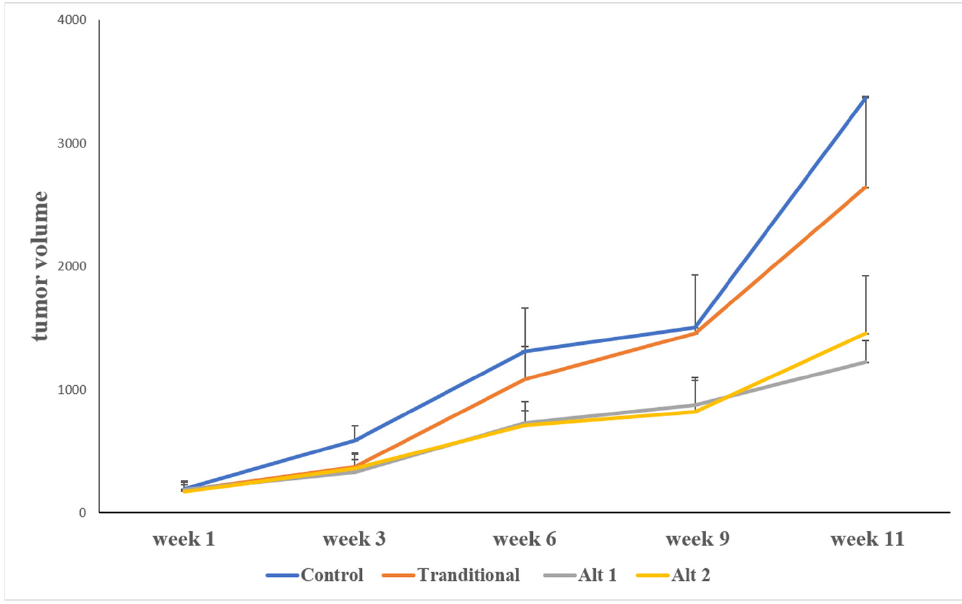
Figure 1. Comparison of tumor growth rates between the different scheduling